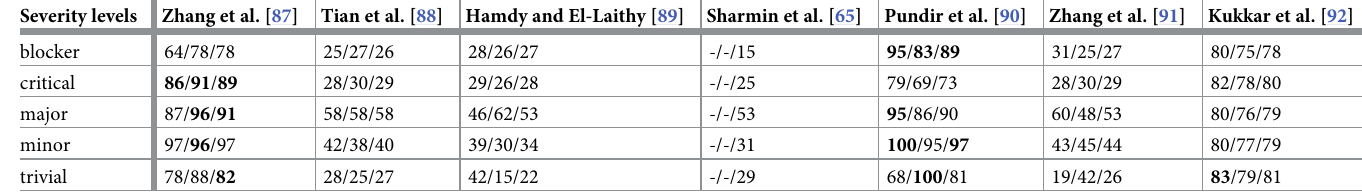
Table 7. Comparison of methods predicting severity. Severity levels are from Bugzilla [46]. The performance is described as precision/recall/f-score with the best results highlighted in bold. All data are shown as